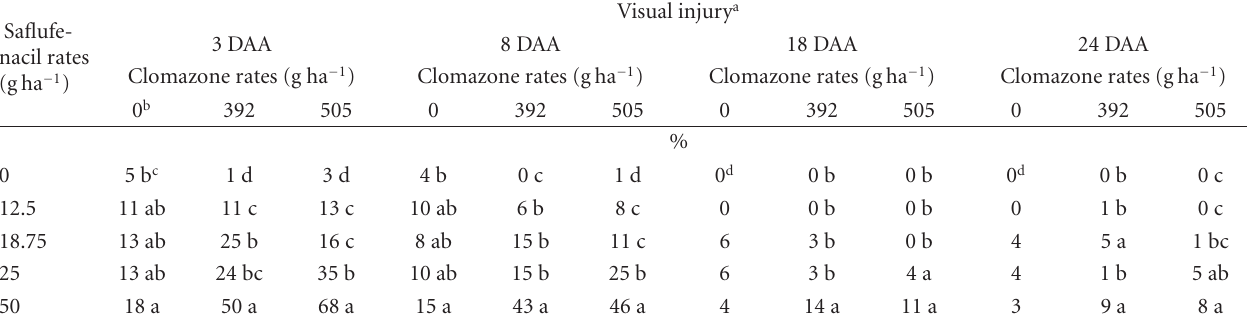
Table 4: Visible rice ( Oryza sativa L.) injury at 3, 8, 18, and 24 days after application (DAA) in response to postemergence application (4- to 6-leaf stage, V4-V6) of saflufenacil following preemergence application of clomazone. Data represents an interaction between rates of saflufenacil and clomazone for experiment conducted in 2009.